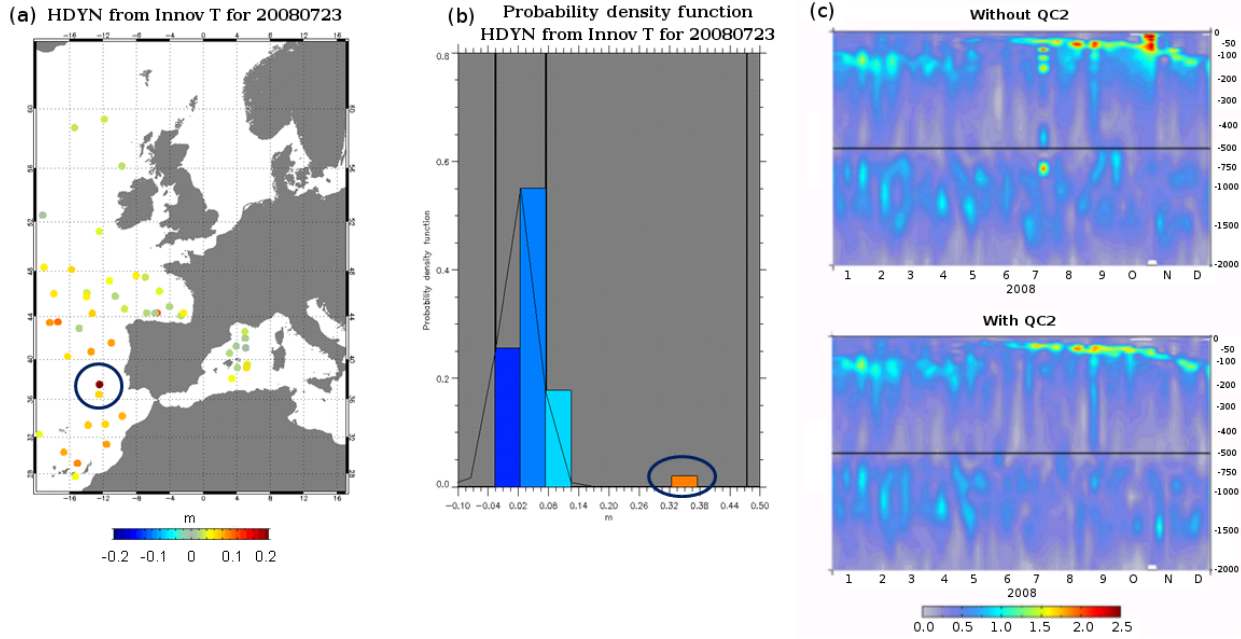
Figure 3. Statistics in the Azores region: (a) absolute value of dynamical height innovations (in meters) from temperature innovations for the 7-day assimilation cycle from 16 to 23 July 2008; (b) PDF of theses dynamical height innovations (the value 0.3m appears in the tail of the PDF); (c) RMS innovation with respect to the vertical temperature profiles over the year 2008 for two “twin” simulations (without and with QC2). Theses last scores are averaged over all 7 days of the data assimilation window, with a lead time equal to 3.5 days. Units are ◦ C.